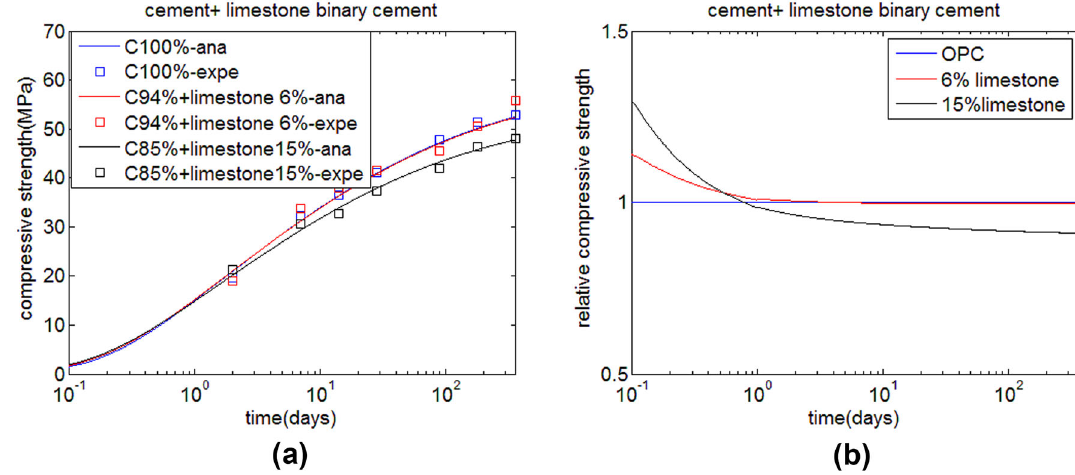
Fig. 7 Strength development of limestone blended concrete. a strength development, b relative strength.